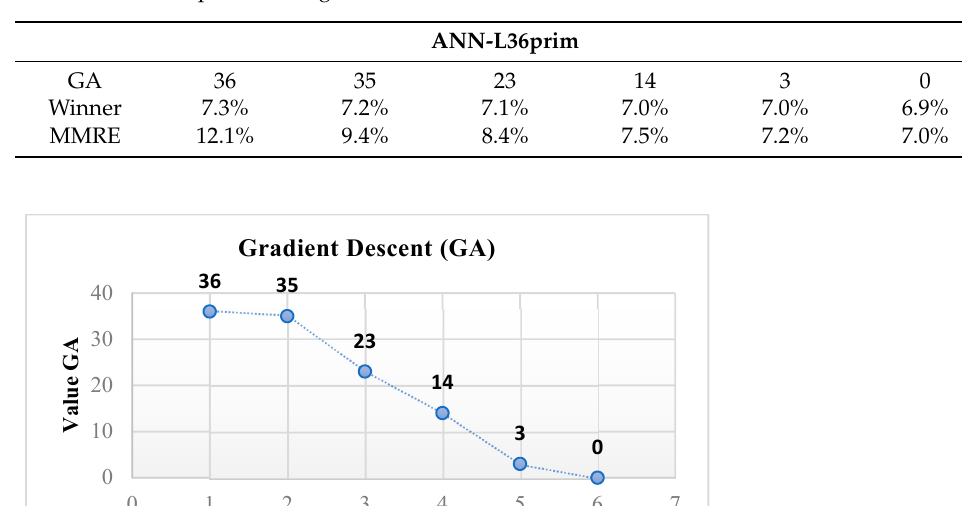
Table 6. ANN-L36prim training results.